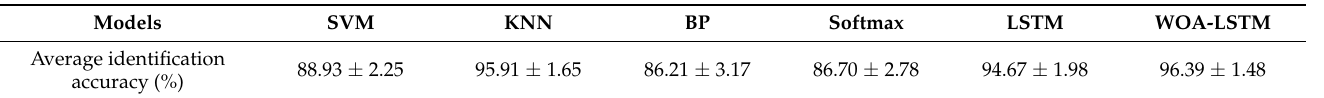
Table 6. Average identification accuracy of different gas recognition models with compound ethylene concentration sample selection strategies.